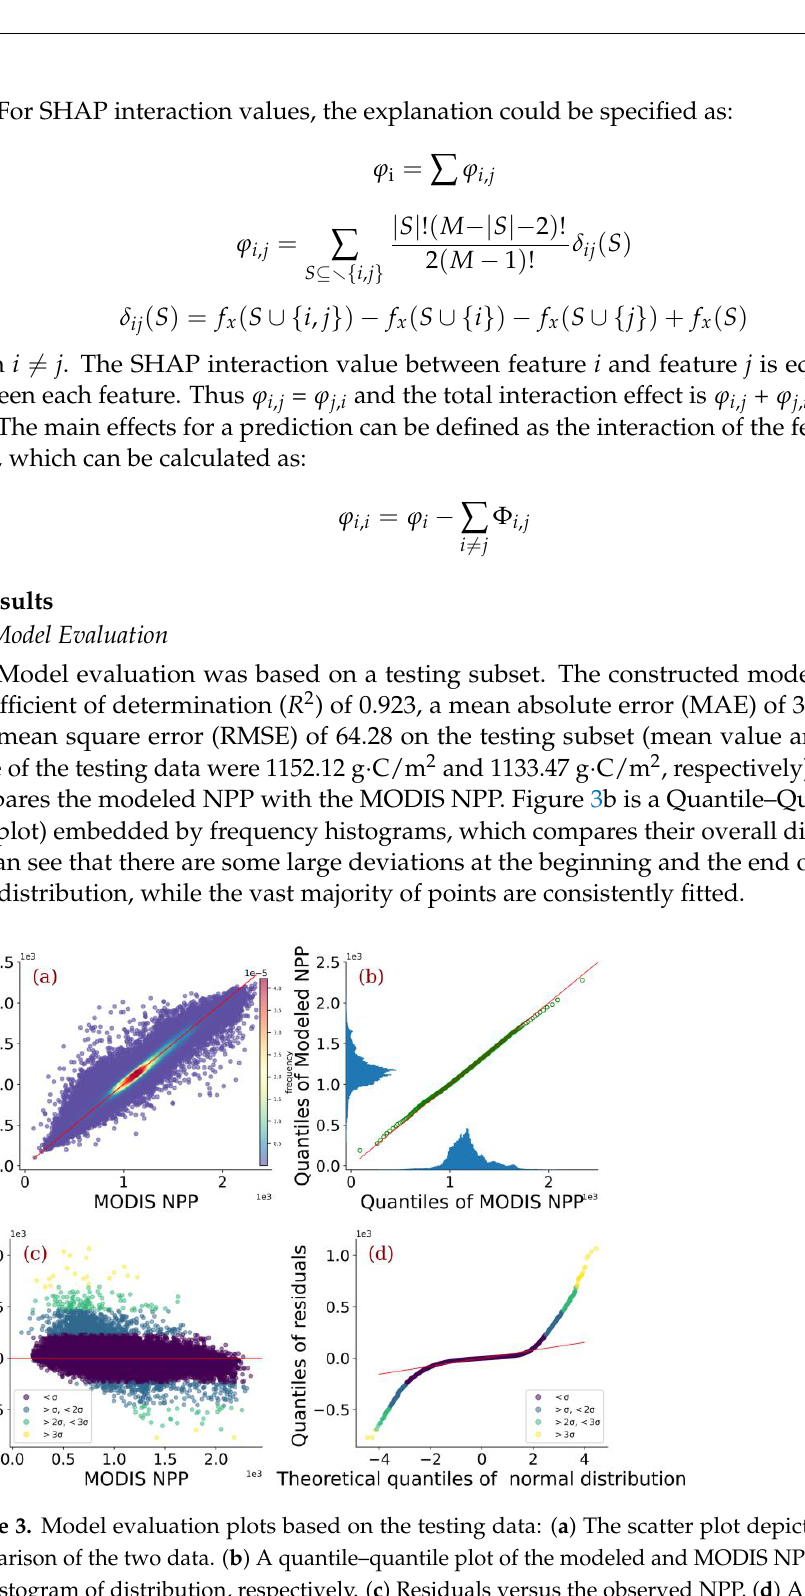
Figure 3. Model evaluation plots based on the testing data: ( a ) The scatter plot depicts a detailed comparison of the two data. ( b ) A quantile – quantile plot of the modeled and MODIS NPP laced with the histogram of distribution, respectively. ( c ) Residuals versus the observed NPP. ( d ) A comparison plot of model residual distribution and a normal distribution. σ indicates the standard deviation of the testing data of MODIS NPP.